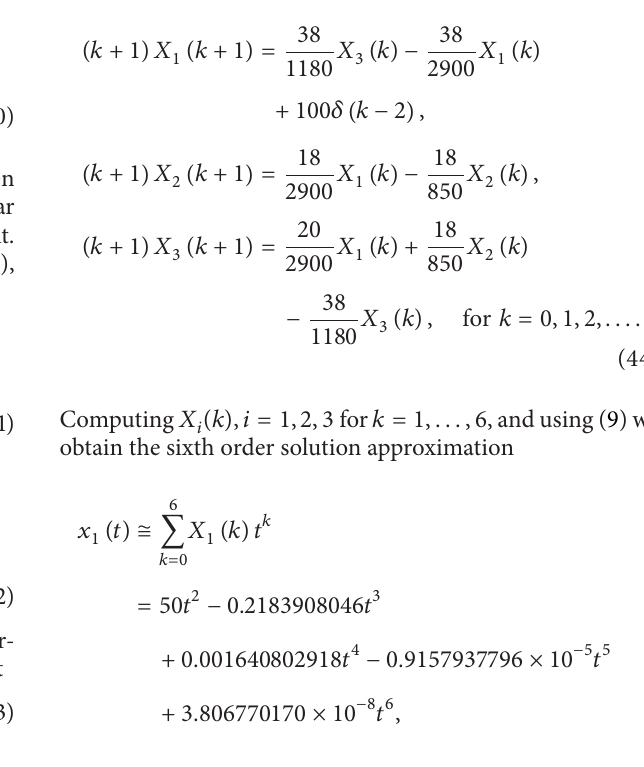
𝑥 (𝑡) = 5.252847334 − 5.280506224𝑒 3